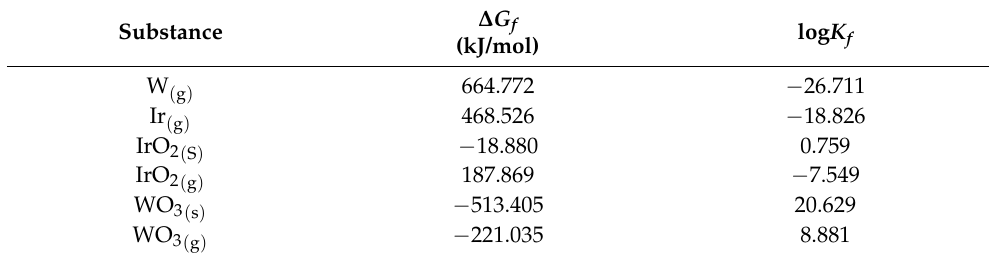
Table 3. Thermodynamic reaction equilibrium constants of various substances at 1300 K [31]. Substance